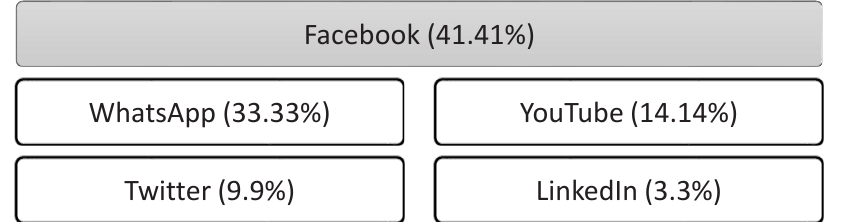
Figure 2. Social networking sites used by